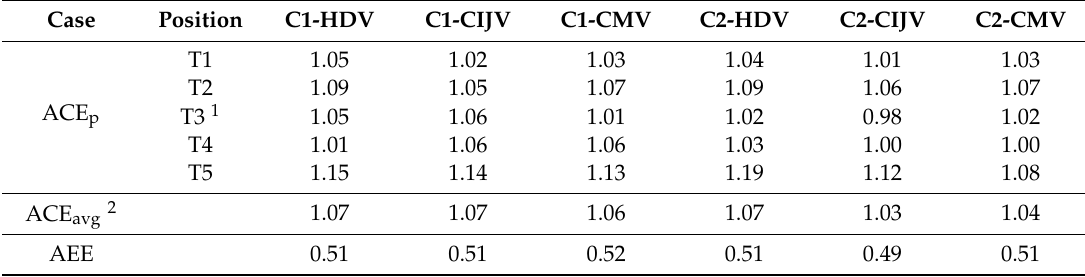
Table 4. Air change e ff ectiveness (ACE), local and average, and air exchange e ff ectiveness (AEE) for all